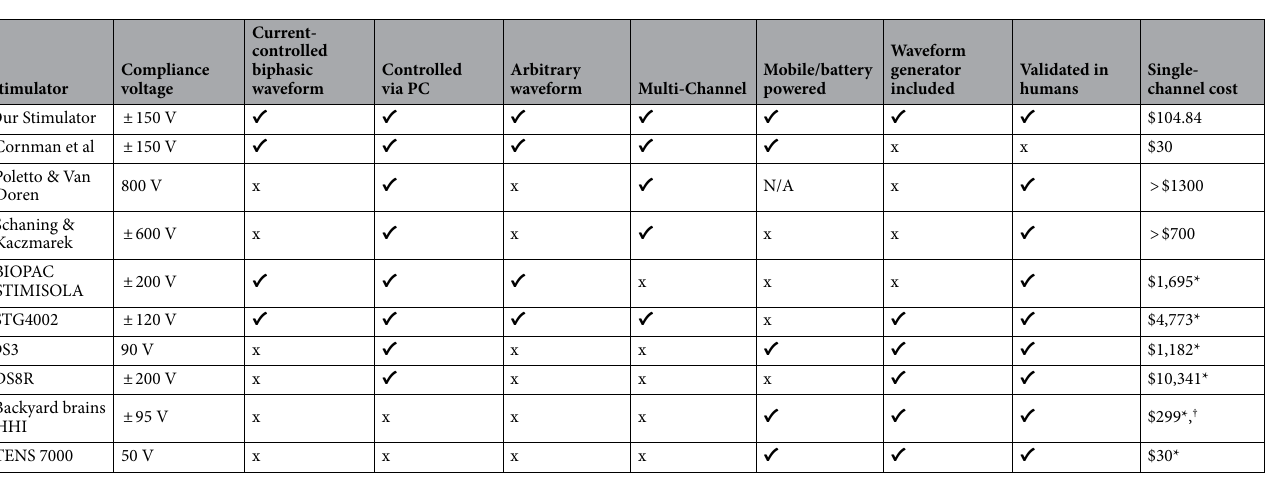
Table 3. Comparison of the qualities of various noninvasive stimulators. *These commercial system’s prices include manufacturing, safety certification, and other associated costs, as opposed to just parts. † The Backyard Brains Human–Human Interface also includes hardware to record electromyography signals and other supporting hardware which is reflected in the